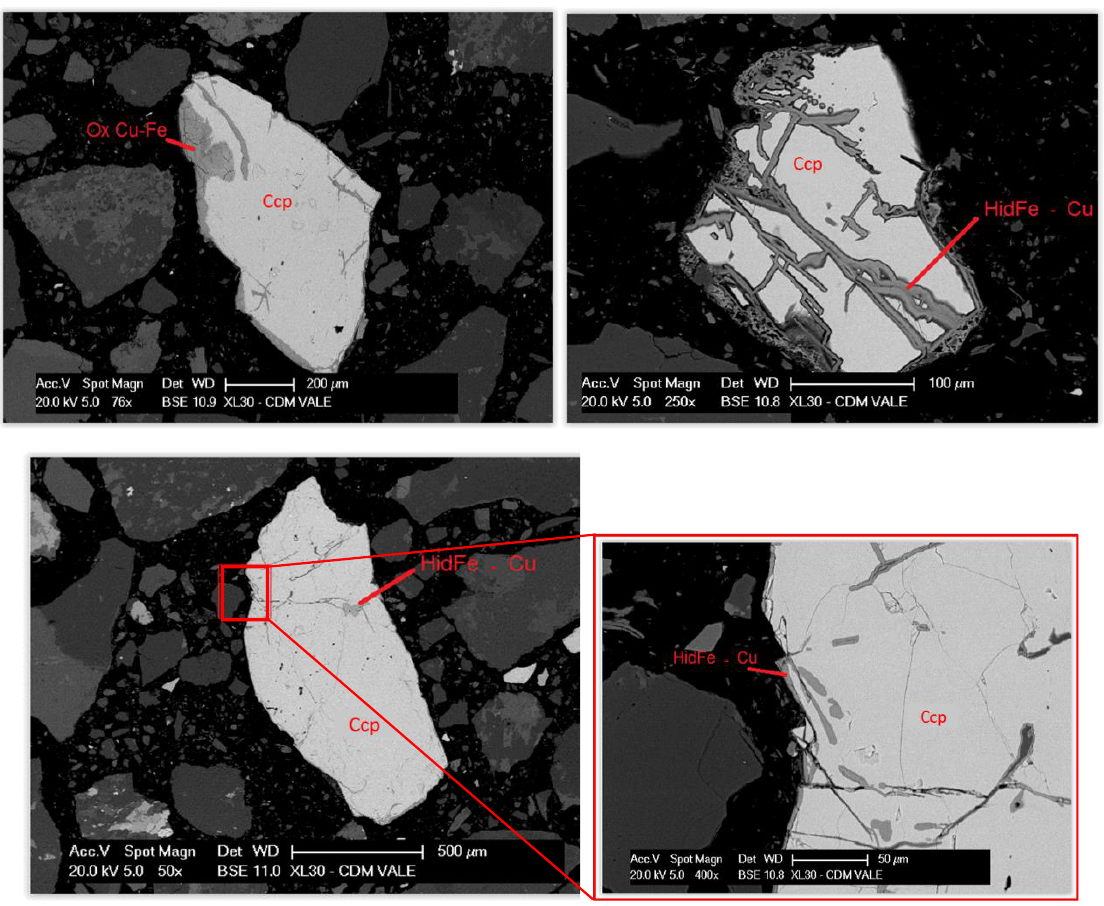
Figure 9. Backscattered electron images of sample 10Y-GRB-1 0, showing chalcopyrite particles that are partially altered to Cu oxides, Cu-Fe oxide, Cu-Fe hydroxides, Cu-Fe oxides.